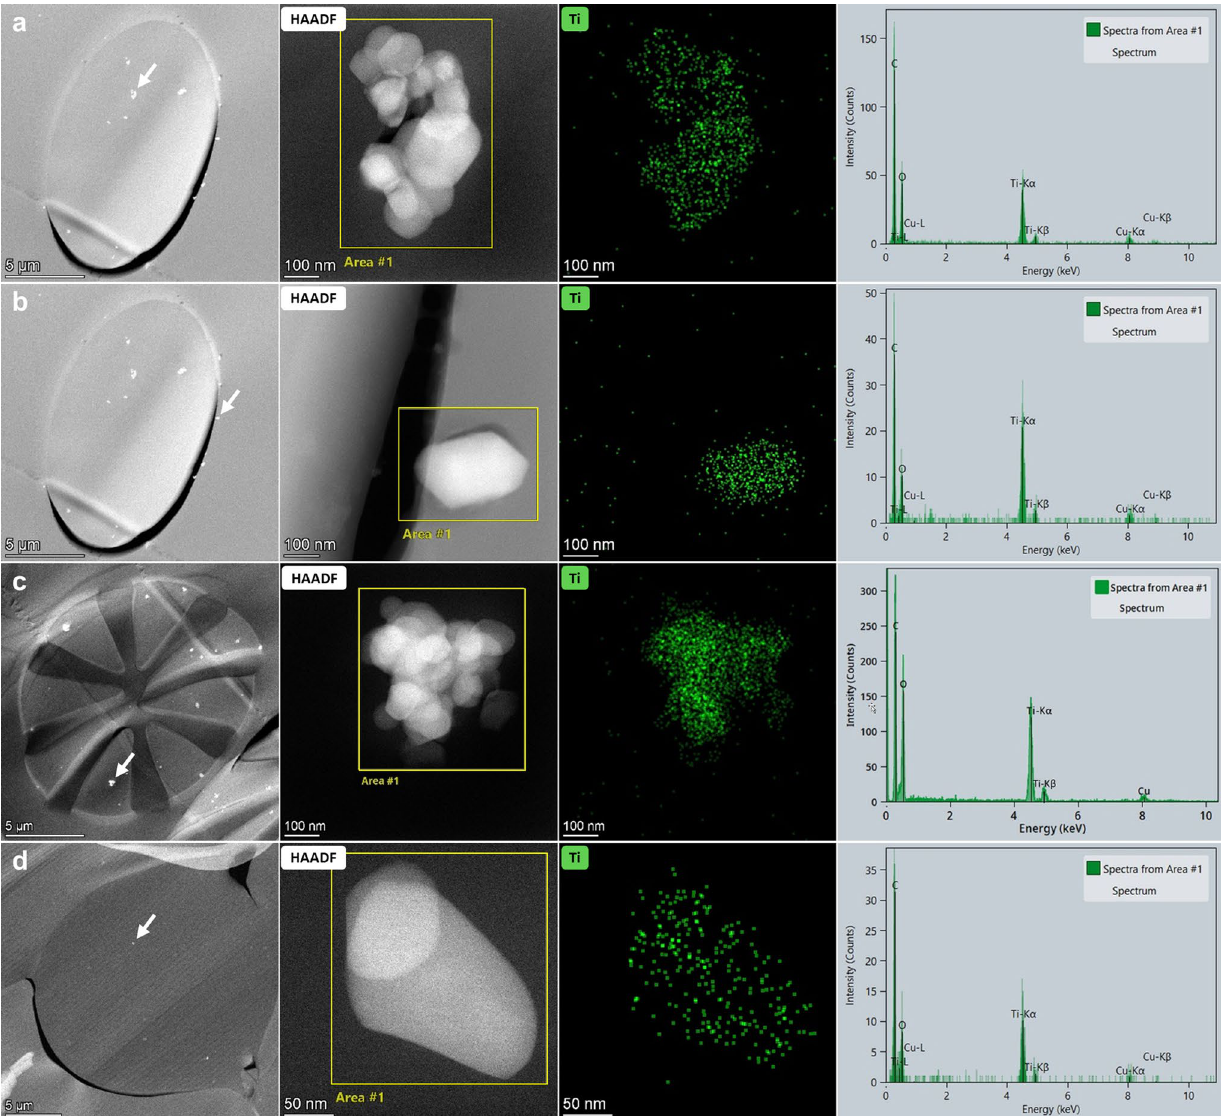
Figure 2. STEM-EDX analysis of particles ( a ) in a polyester fiber, ( b ) at the edge of a polyester fiber, ( c ) in a bi-component microfiber and ( d ) in a non-woven fabric. (first column) The low magnification HAADF- STEM images show the cross sections of the fibers containing the analyzed particles (white arrows) shown in the (second column) higher magnification HAADF-STEM images. (third column) The spectral images of Ti (green) obtained by EDX show that the measured Ti signal coincides with the position of the particles shown in the STEM image, and (fourth column) the EDX spectra of the area’s indicated on the STEM image show the Ti